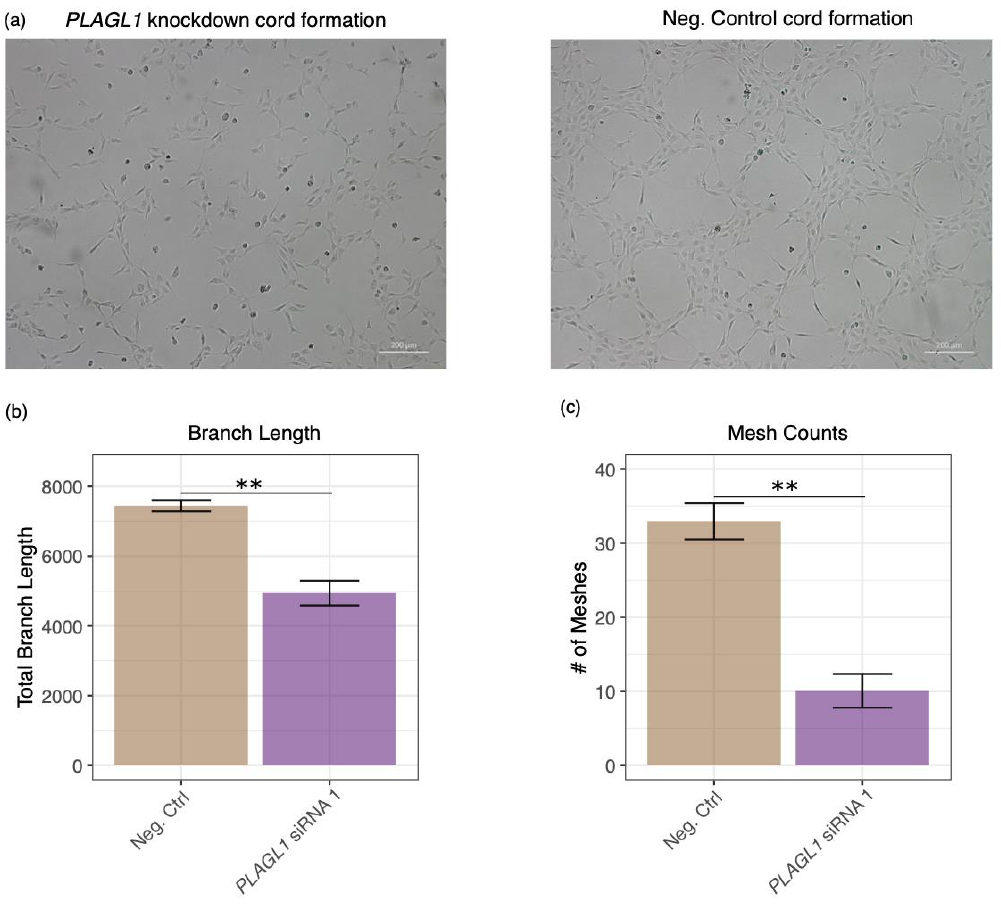
Figure 6. PLAGL1 knockdown decreases cord formation ability in HTR-8 / SVneo cells. ( a ) Representative images showing cord formation is reduced after PLAGL1 is knocked down (left) compared to a control (right). ( b ) Branch length was significantly reduced after PLAGL1 knockdown ( p -value ≤ 0.01(**)). ( c ) Enclosed regions, or meshes, were significantly reduced after PLAGL1 knockdown ( p -value ≤ 0.01(**)).